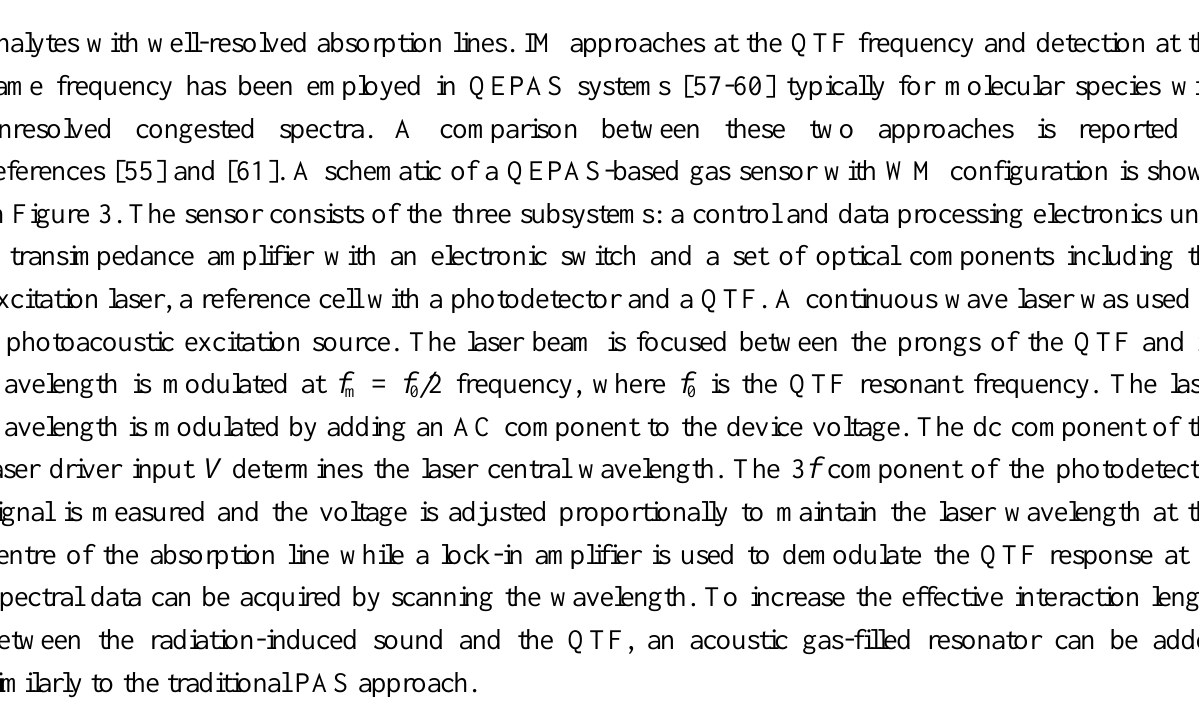
Figure 3. Schematic of the QEPAS trace gas sensor using a quantum cascade laser as an excitation source. (Reproduced with kind permission form Springer Science and Business Media